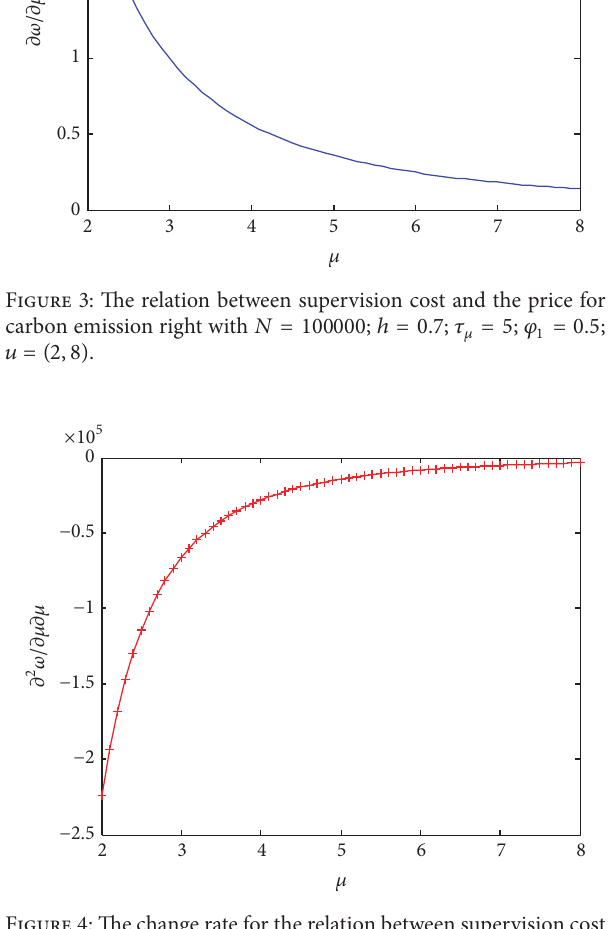
Figure 4: The change rate for the relation between supervision cost and the price for carbon emission right with 𝑁 = 100000 ; ℎ = 0.7 ; = 5 ; 𝜑 = 0.5 ; 𝑢 = (2,8) . 𝜏 𝜇 1